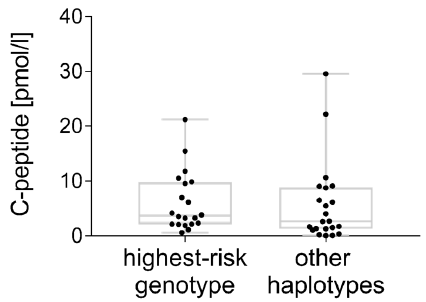
Figure 3. Ultrasensitive residual C-peptide concentrations (pmol/L) compared between patients with